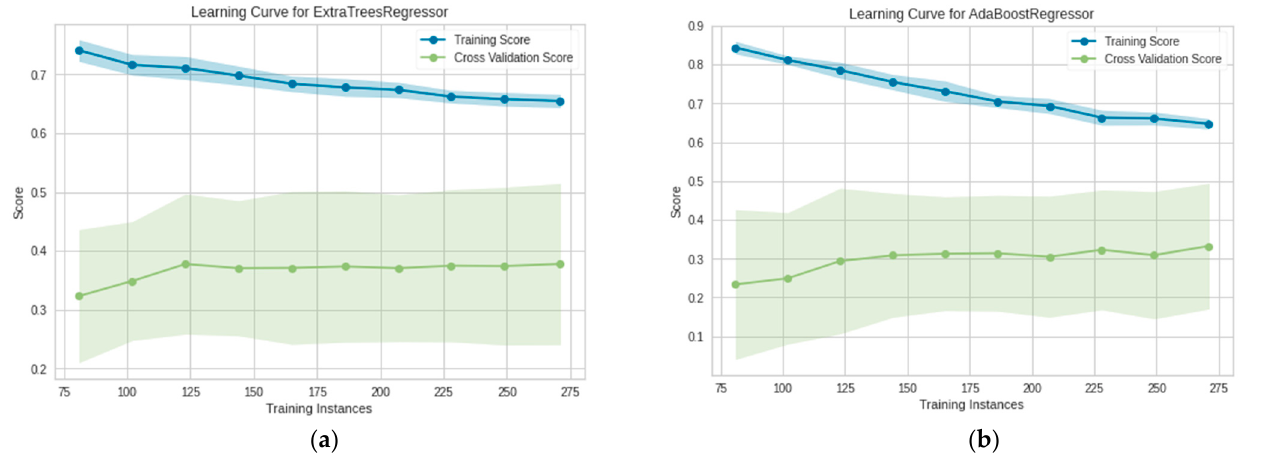
Figure 10. Learning curve of of ( a ) Extra Tree; ( b ) AdaBoost.